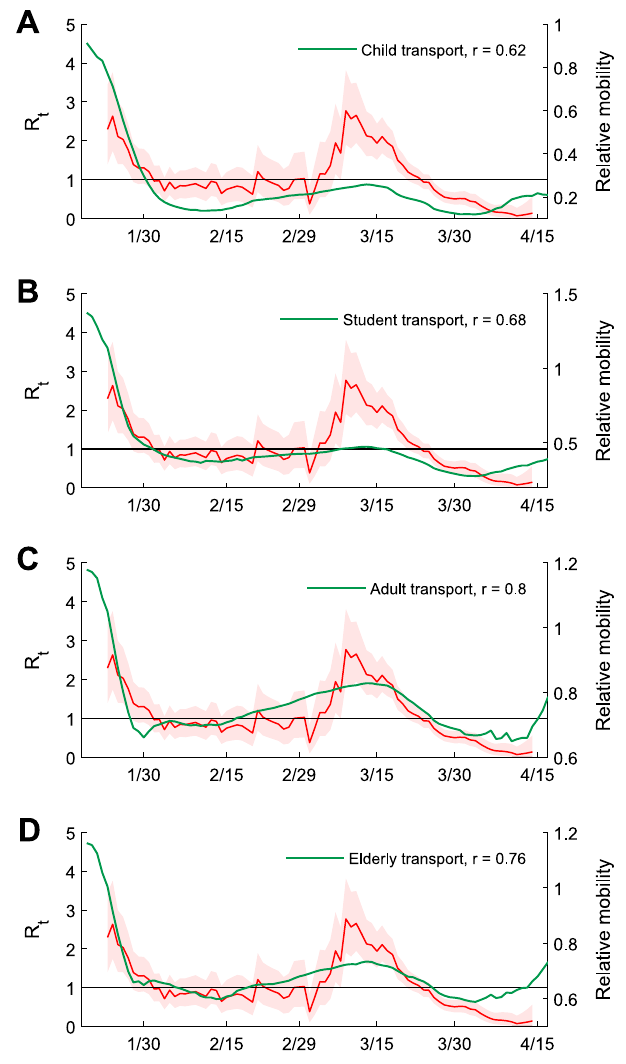
Fig. 2 Correlation between transmissibility of COVID-19 and mobility levels inferred from Octopus transport data in Hong Kong. A – D Correlation with Octopus transport data (7-day moving average) of children, students, adults, and the elderly. Red lines and shades indicated the posterior mean and 95% credible intervals of local R t estimates from Fig.